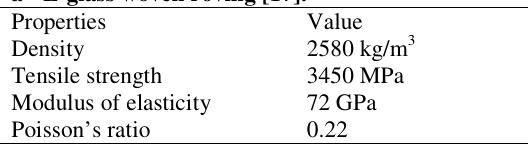
Physical and mechanical properties of fiber: a- E-glass woven roving